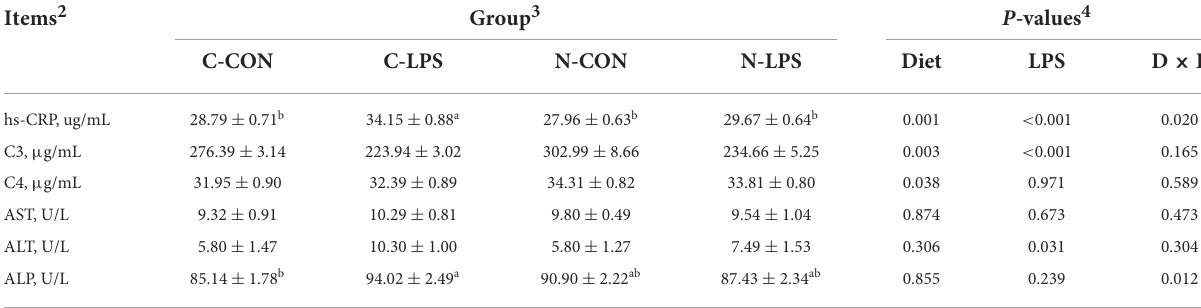
TABLE 3 Effects of maternal nucleotide supplementation on the serum parameters in lipopolysaccharide-challenged newborn piglets 1